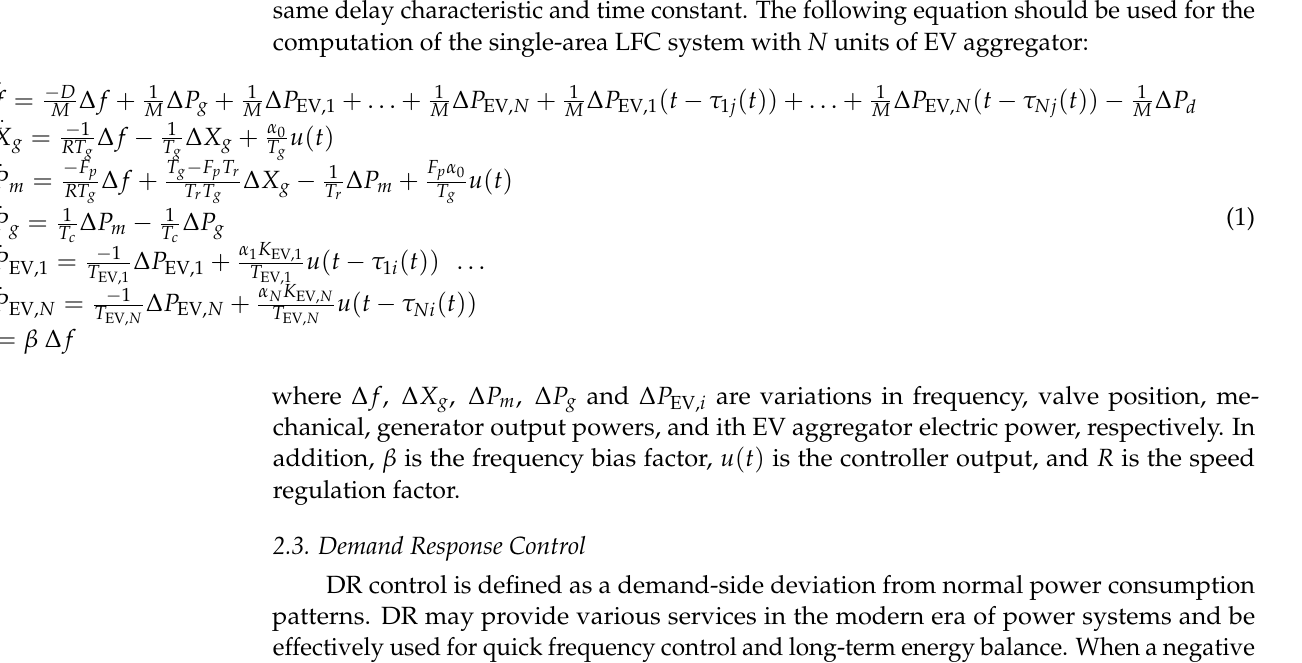
Figure 2. Multiple EV aggregators in the LFC system considering time-varying delays.